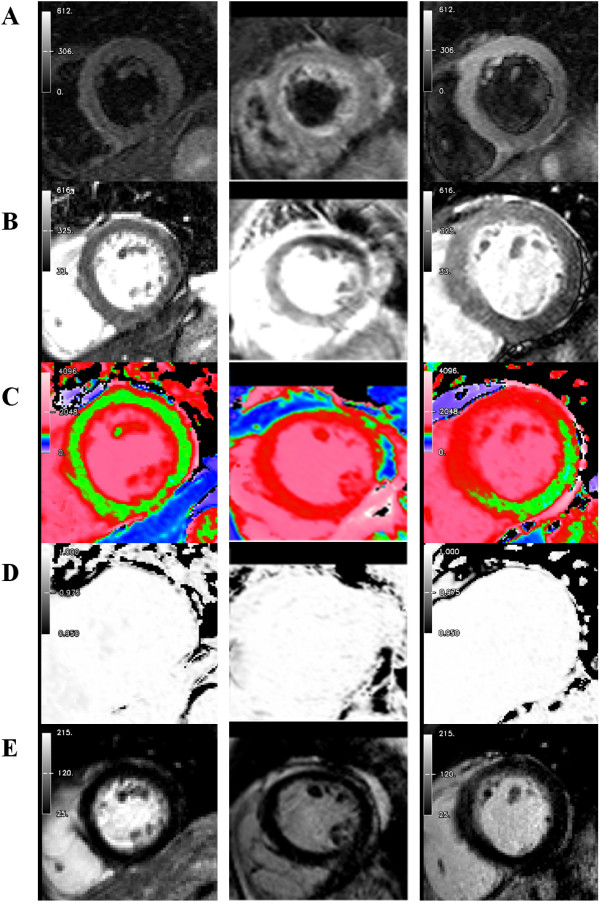
CMR imaging modalities used for comparison – representative images in short-axis slices from: (Left panel) Normal volunteer (Middle panel) Patient with Takotsubo cardiomyopathy. Note high T2 signal and T1 values in an apical slice. (Right panel) Patient with regional edema in the anterior wall territory. Note high T2 signal and T1 values in the anterior, anterolateral wall and anterior septum. Rows: (A) Dark-blood T2-weighted images (reference ROIs in skeletal muscle and remote myocardium not shown). (B) Bright-blood T2-weighted images. (C) Colour ShMOLLI T1-maps. Green denotes normal myocardium. Red denotes increased T1 values (D) R2 maps of ShMOLLI inversion recovery fit used to verify the quality of T1-maps. (E) LGE imaging.